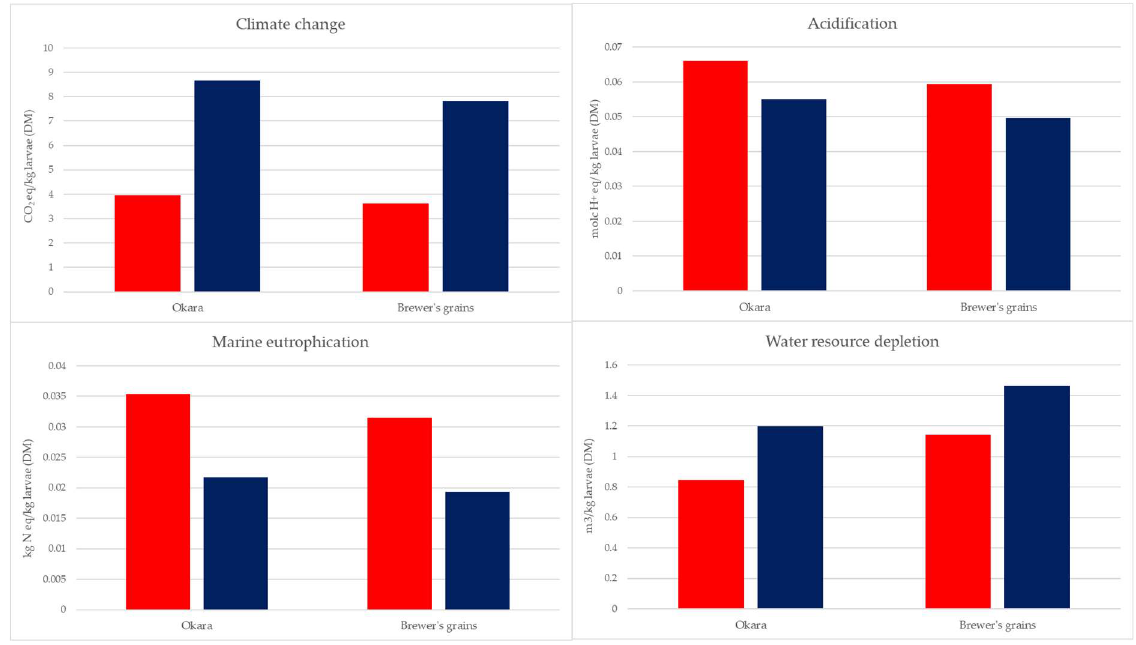
Figure 6. Sensitivity analysis: environmental impact evaluation substituting okara and brewer’s grain with sunflower meal (red bar) or soybean meal (blue bar) based on protein content.